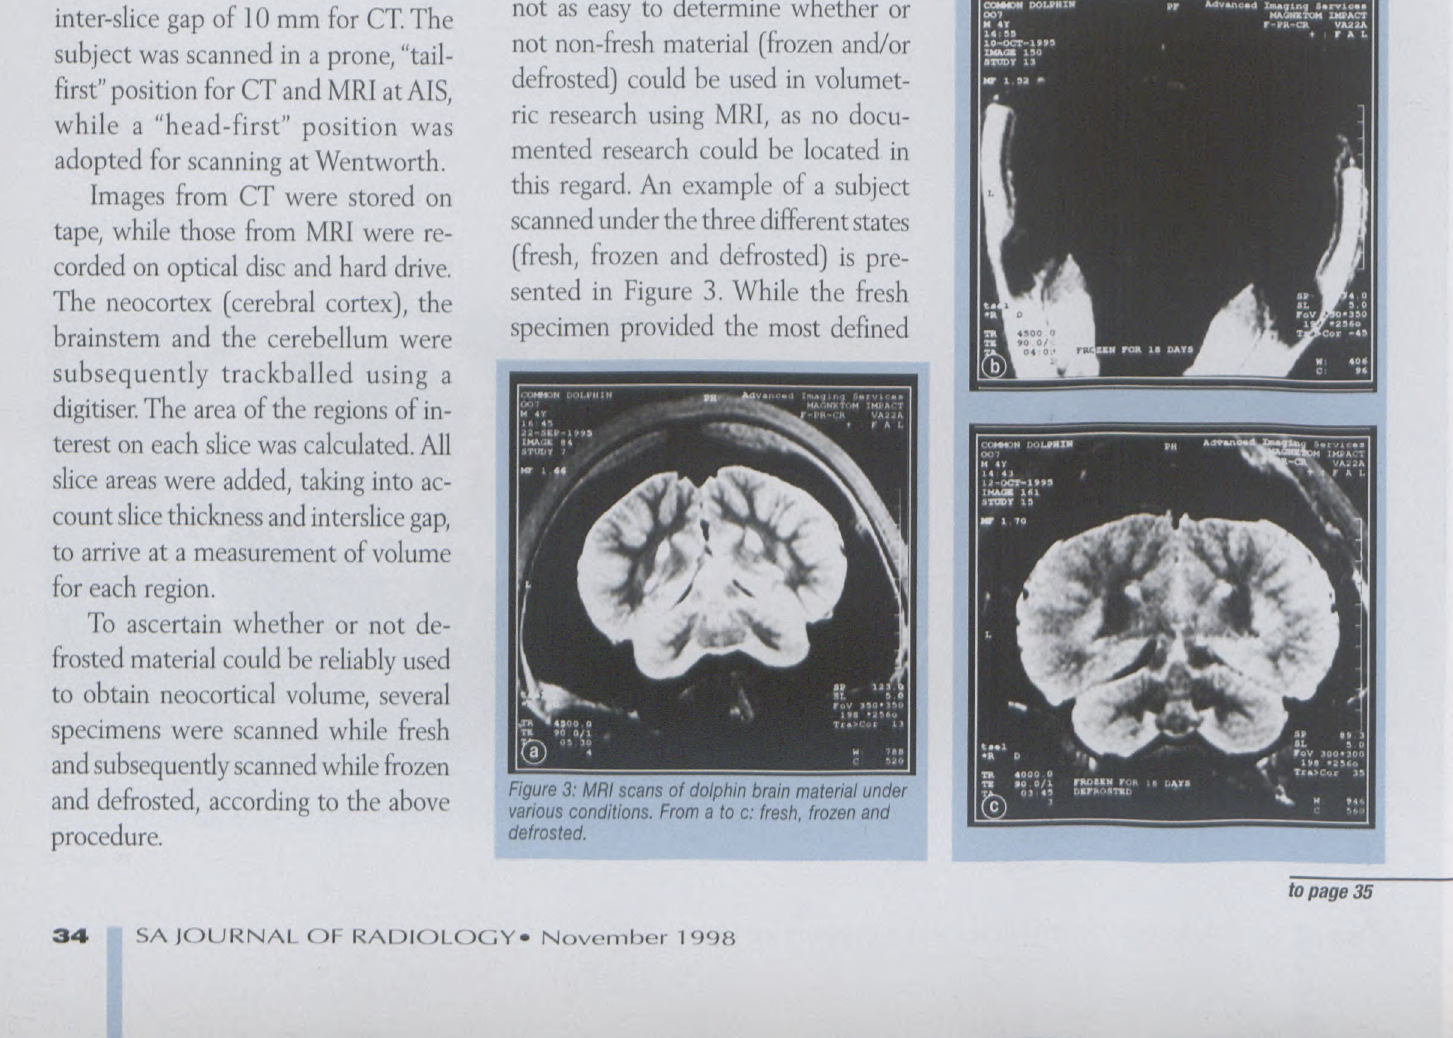
Figure 2: MRI image of a dolphin brain, displaying neocortex A - cerebral cortex, B - brainstem and C - cerebellum.